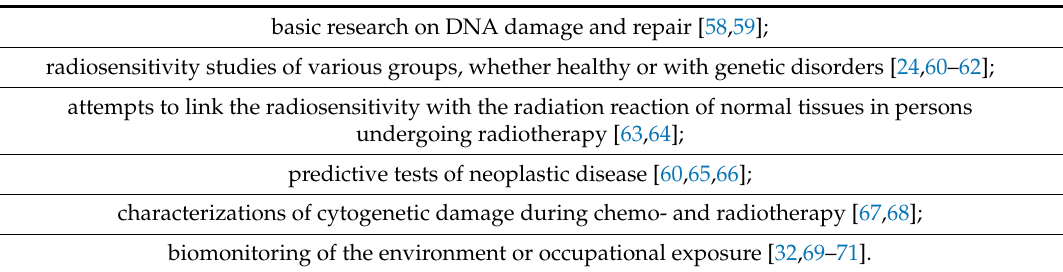
Table 4. Application of